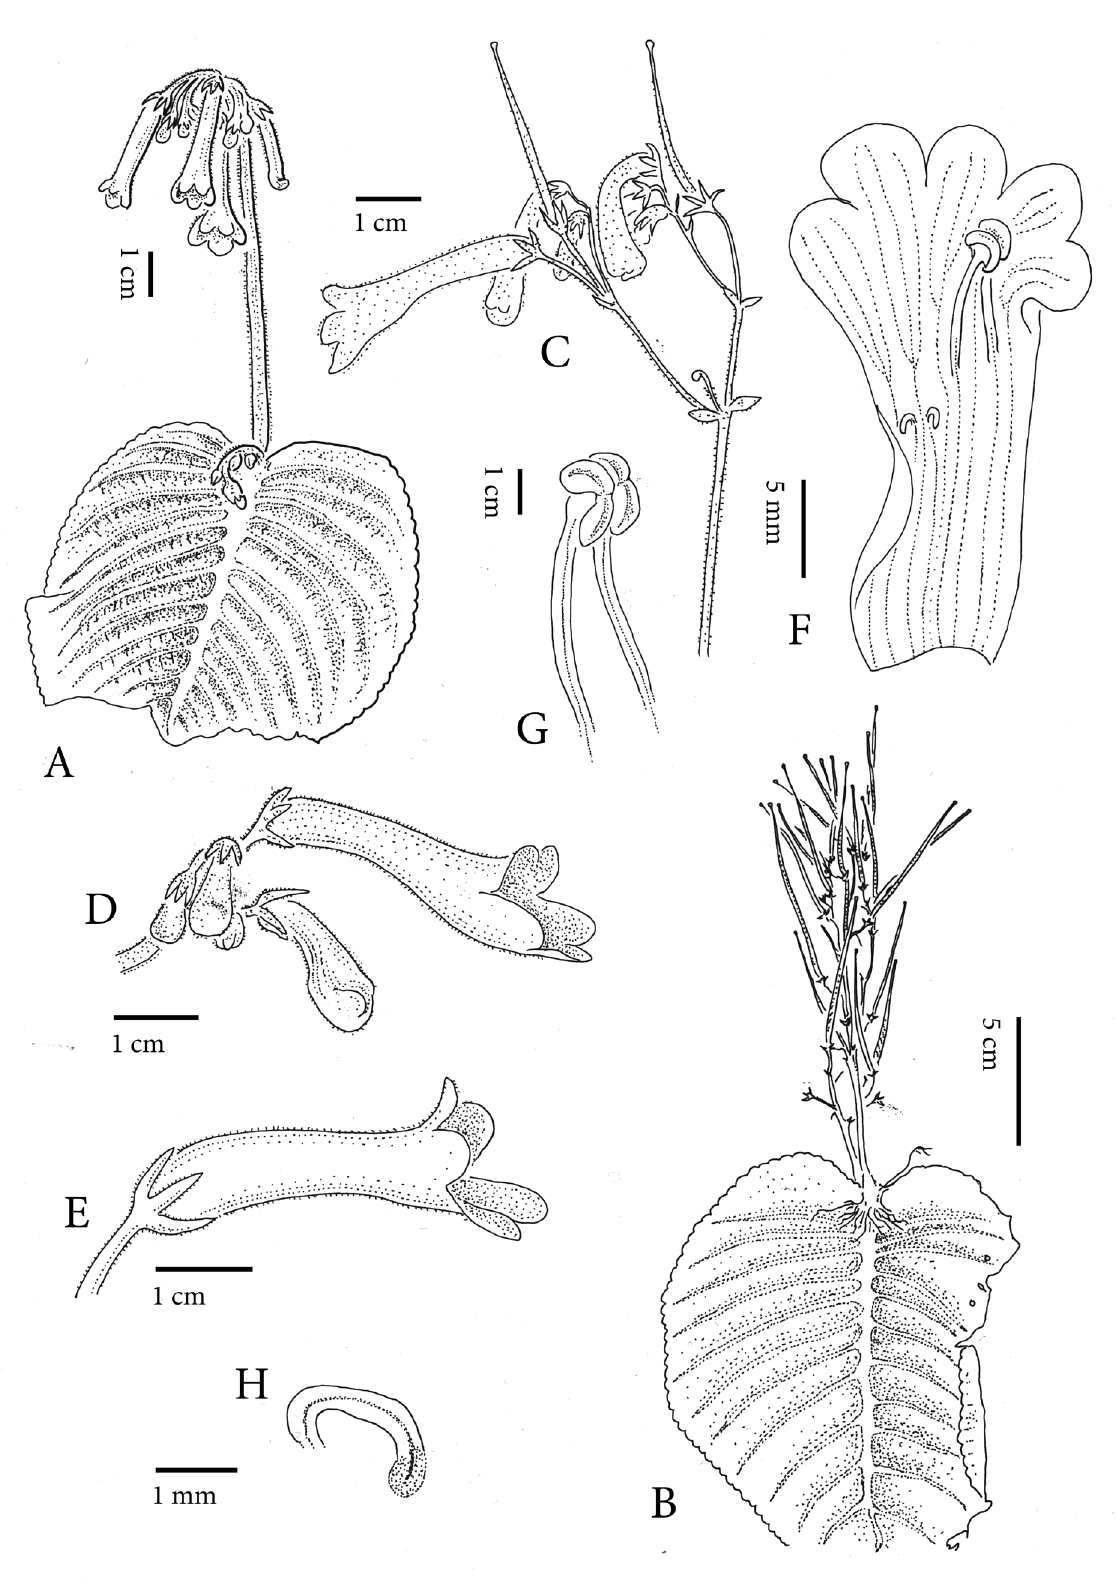
Figure 7 – Streptocarpus schaijesii. A – B . Habit. C – D . Partial inflorescence. E . Flower, lateral view. F . Corolla dissected, showing position of stamens and staminodes. G . Stamens. H . Staminode. A, C–H from Schaijes 1695 and B from Malaisse 13809 . Illustration by Eberhard